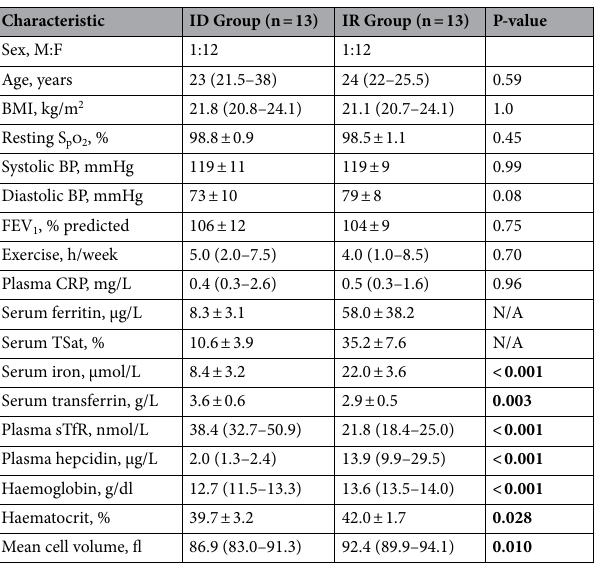
Table 1. Participant characteristics on enrolment. For normally distributed data, comparisons are by t-test and values are means ± SD. For non-normally distributed data, comparisons are by Mann Whitney U test and values are medians (IQR). Statistically significant P-values appear in bold. ID, iron deficient; IR, iron replete; BMI, body mass index; S p o 2 , peripheral oxyhaemoglobin saturation; FEV 1 , forced expiratory volume in one second; CRP, C-reactive protein; TSat, transferrin saturation; sTfR, soluble transferrin